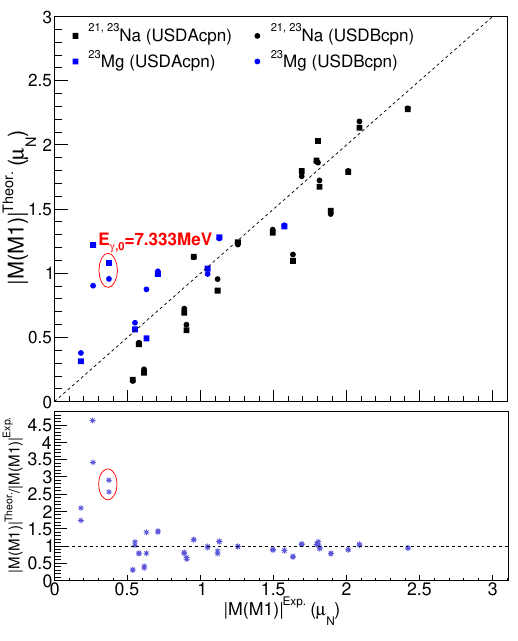
Figure 2. Correlation between measured and theoretical reduced matrix elements | M ( M 1) | values for transitions in 23 Mg and 21 , 23 Na [30] . Theoretical values were obtained from sd -shell calcula- tions with USDAcpn and USDBcpn [25, 26], experimental ones from measured ( τ , E γ, 0 ), resulting in rms = 0.322 µ N (USDAcpn) and rms = 0.273 µ N (USDBcpn). It follows that the largest relative deviations are observed for the lowest | M ( M 1) | values, as for the E x = 7.785 MeV state shown in the red